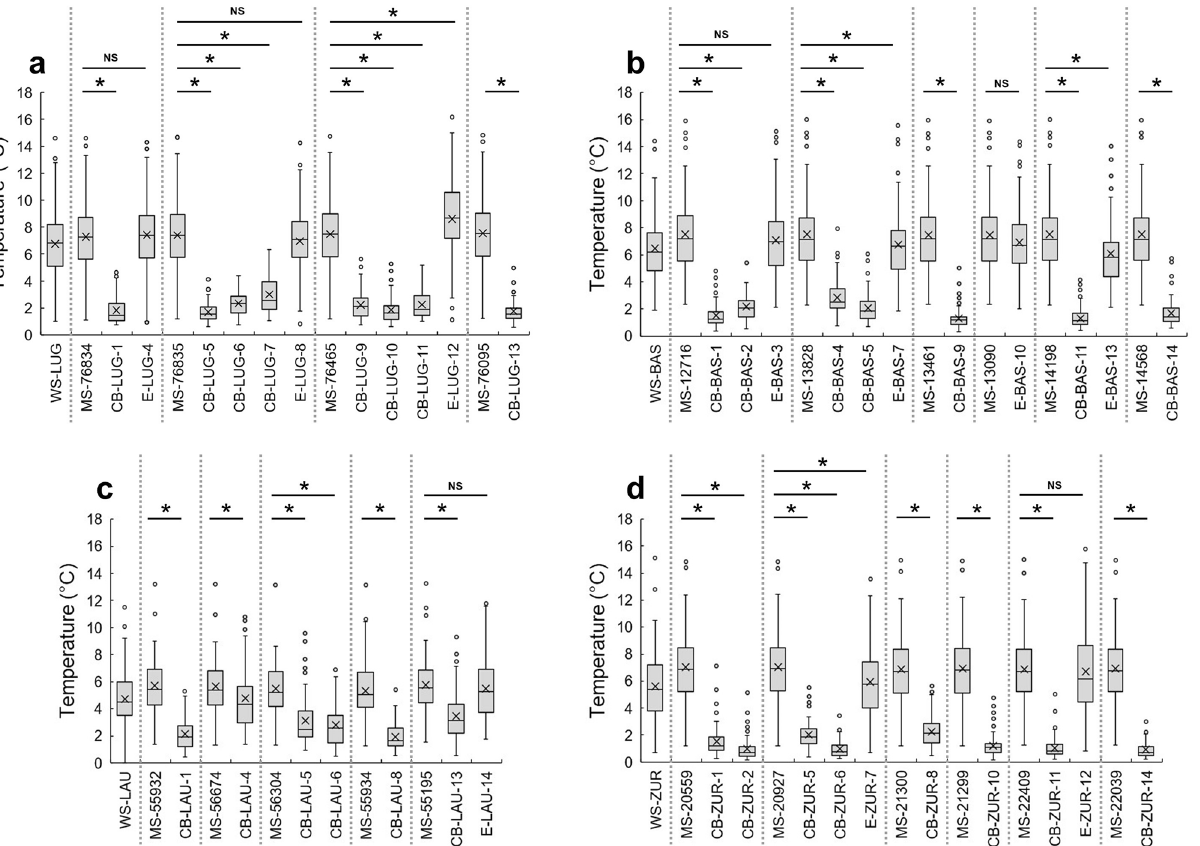
Figure 1. Daily temperature ranges in the cities of Lugano ( a ), Basel ( b ), Lausanne ( c ) and Zurich ( d ). The x marks within the boxes represent the means. Temperatures were recorded at permanent weather stations (WS), MeteoSwiss cells (MS) and corresponding catch basins (CB) and external potential warm-season resting habitats (E) (Supplementary Table S1). *: Significant differences. NS: differences not